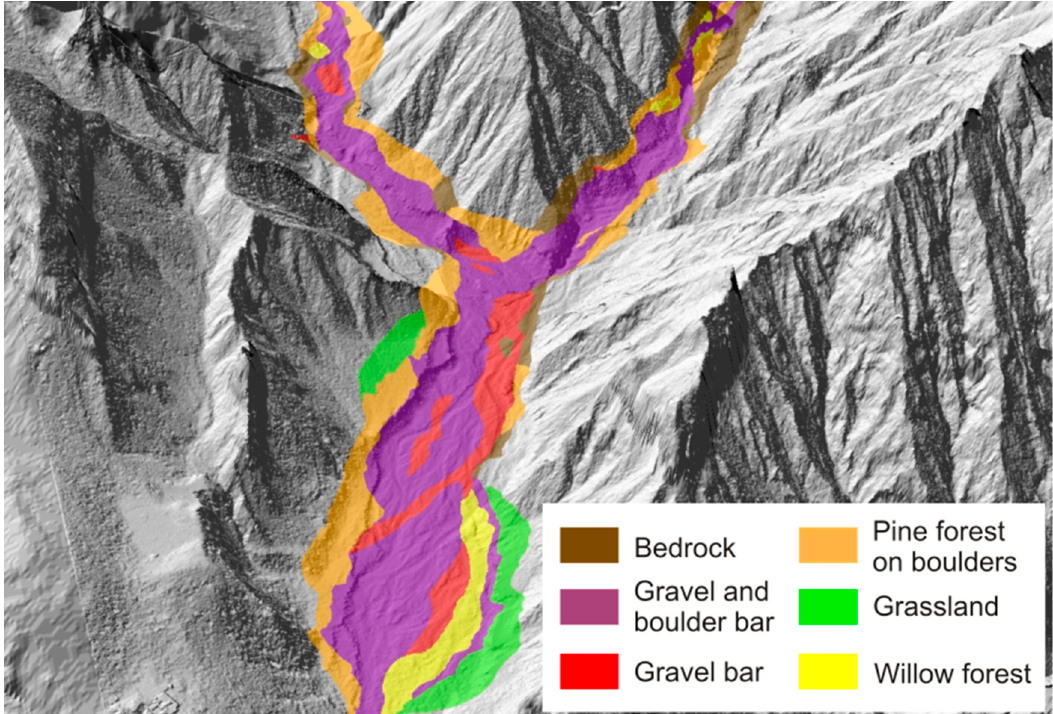
Figure 4. Generated 3D mesh for hydraulic simulation of floods (Iber software). Terrain roughness ( n Manning coefficient) map is overlapped to mesh to allow identification of homogeneous areas. Surface roughness classes and associated coefficients are bedrock ( n = 0.04), gravel and boulder bar ( n = 0.055), gravel bar ( n = 0.035), pine forest on boulders ( n = 0.05), grassland ( n = 0.035), willow forest ( n = 0.07), and disperse vegetation ( n = 0.06).